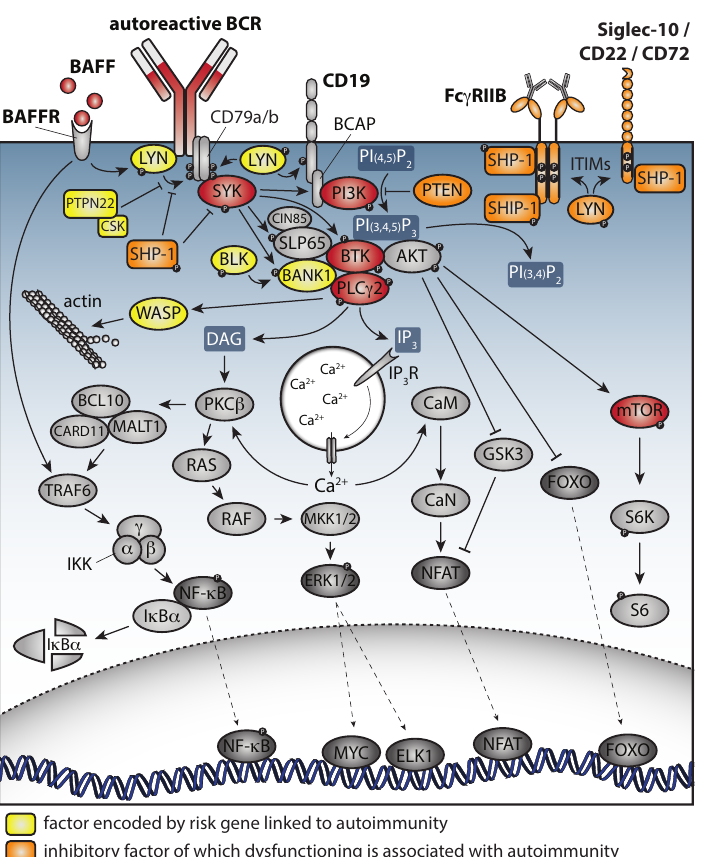
Figure 2. Signaling molecules downstream of the B cell receptor that are associated with autoimmu- nity. The signaling pathway downstream of the B cell receptor (BCR) contains signaling molecules that are partially shared with other pathways. In particular, the BAFF receptor provides essential survival signals and the CD19 co-receptor, which is intimately connected to the BCR. Inhibitory signals are provided by the kinase CSK and various phosphatases, including SHIP-1 and SHP-1, the activity of which is induced by Siglec-10, Fc γ RIIb, and CD22 surface receptors, as well as PTEN and PTPN22. Highlighted signaling molecules have been linked to an increased risk in the development of autoimmune disease (yellow), have crucial inhibitory function in BCR signaling by preventing autoimmunity (orange), or show increased expression and/or activity in B cells from autoimmune disease patients (red). Signaling molecule abbreviations are explained in the